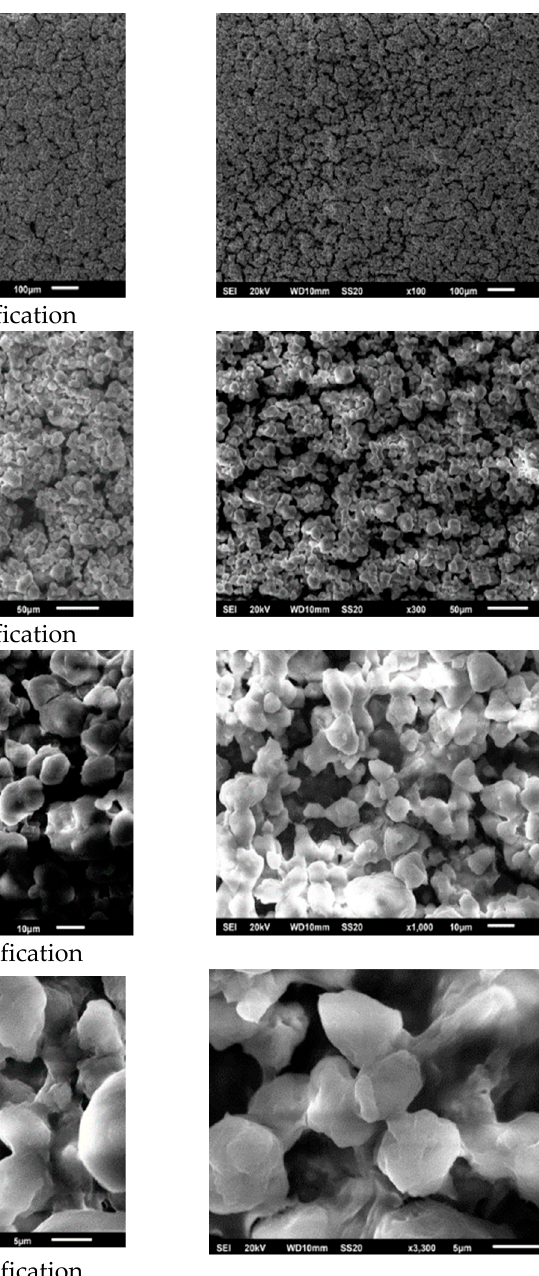
Figure 7. SEM images of the surface of the Fe-Cr-Al foil with the supported secondary carrier at various magnifications.